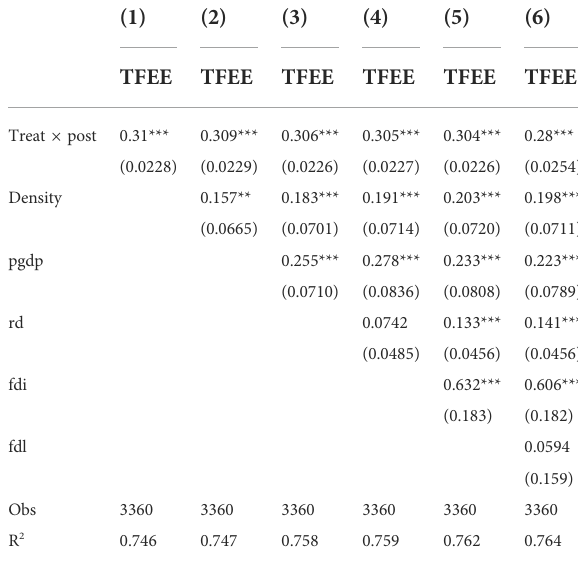
TABLE 2 Impact of GFPP on